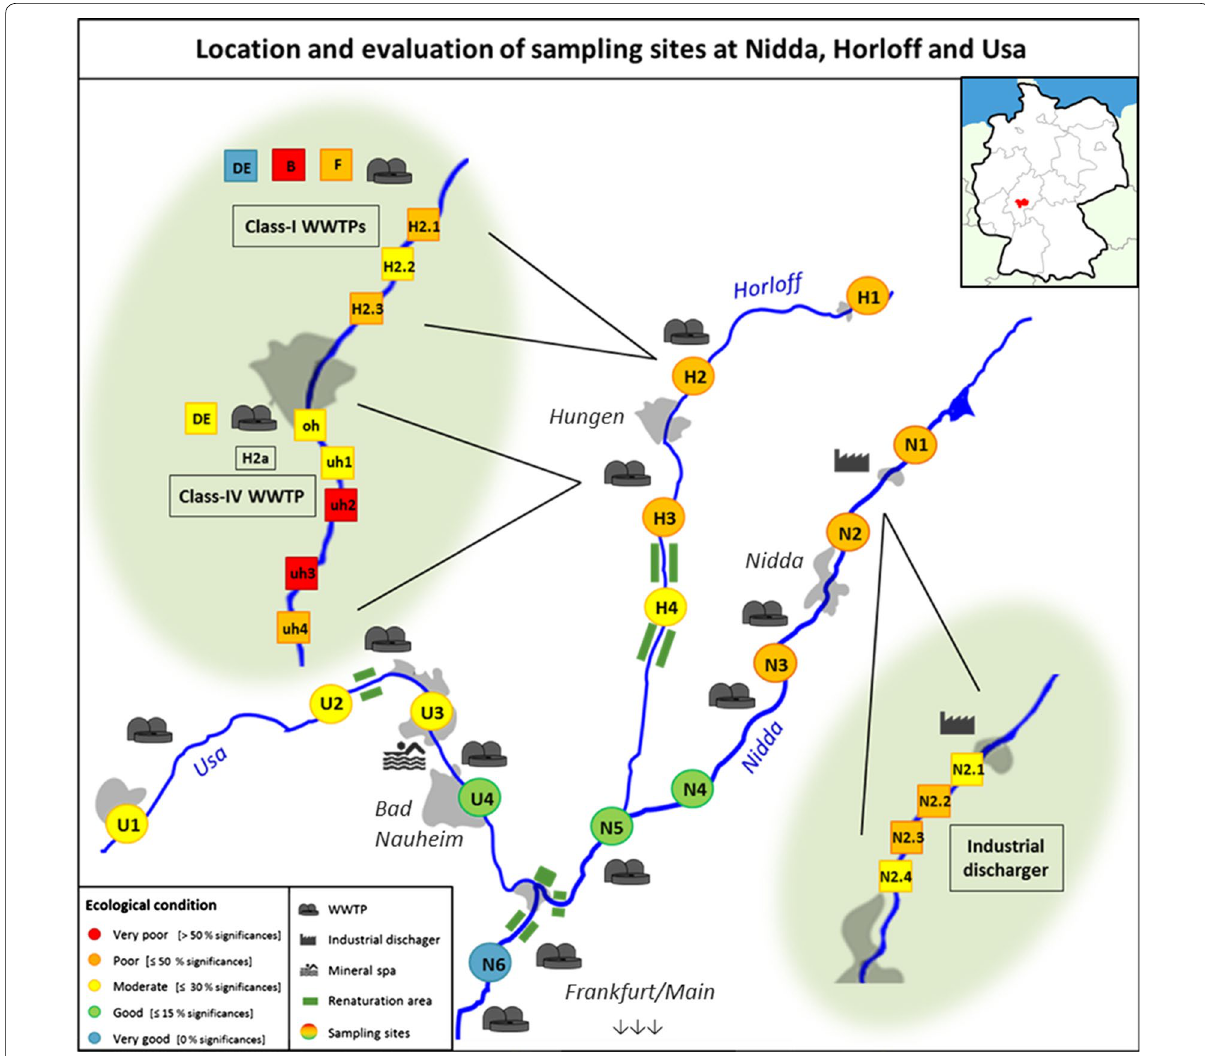
Fig. 1 Map of the sampling area in Central Hesse, Germany including locations of sampling sites and their evaluation based on the percentage of significant endpoints compared to control treatments, as well as prominent points of discharge. Round tags mark the main sampling sites, square tags the additional sites, including the samples taken from the efflux pipes (DE), the basin (B) and the zone of effluent and river mixture